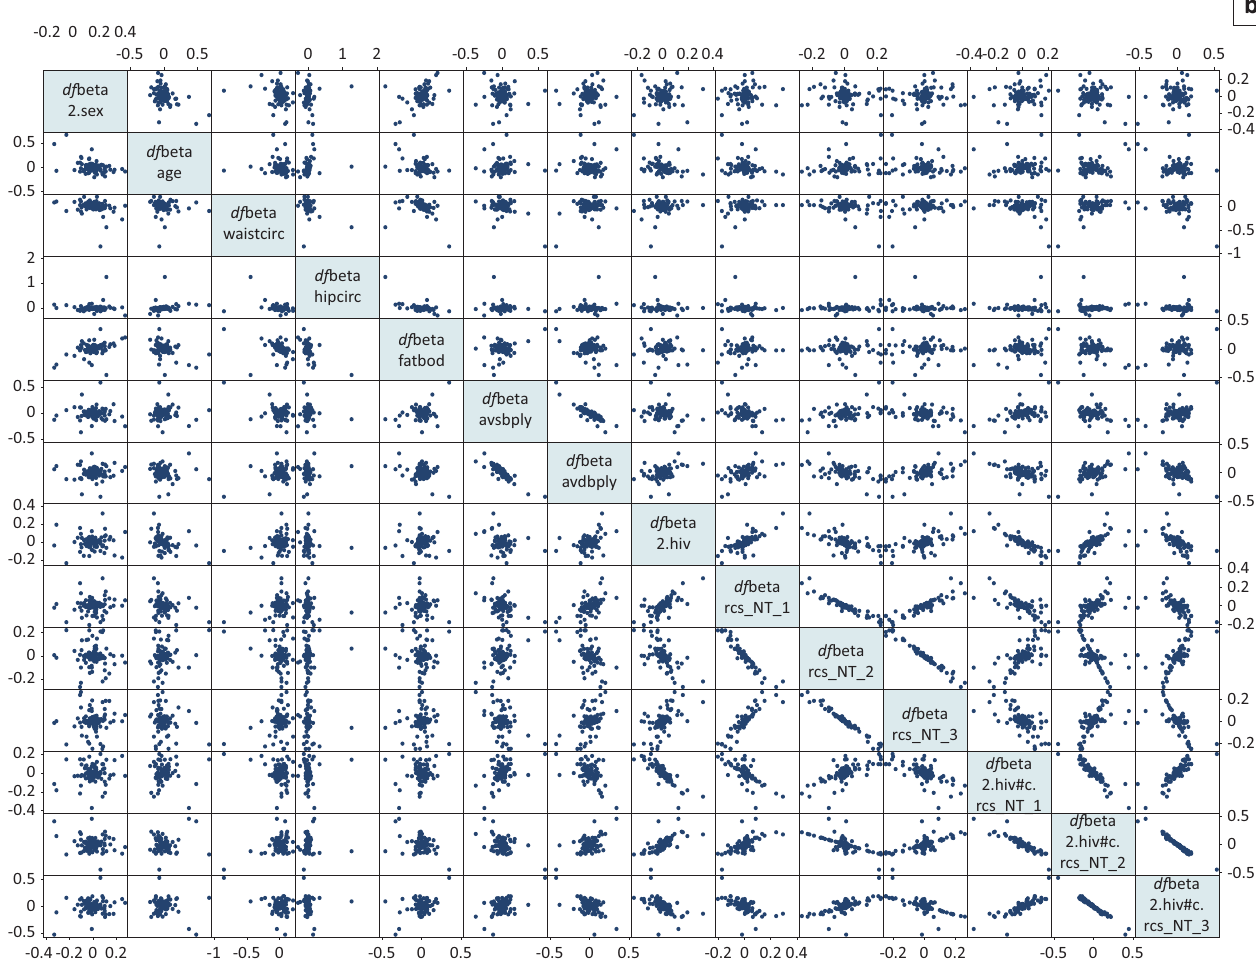
FIGURE 1-A1 (Continues…): Scatter plot matrix of data showing all possible plots for specified variables with df beta for linear regression.